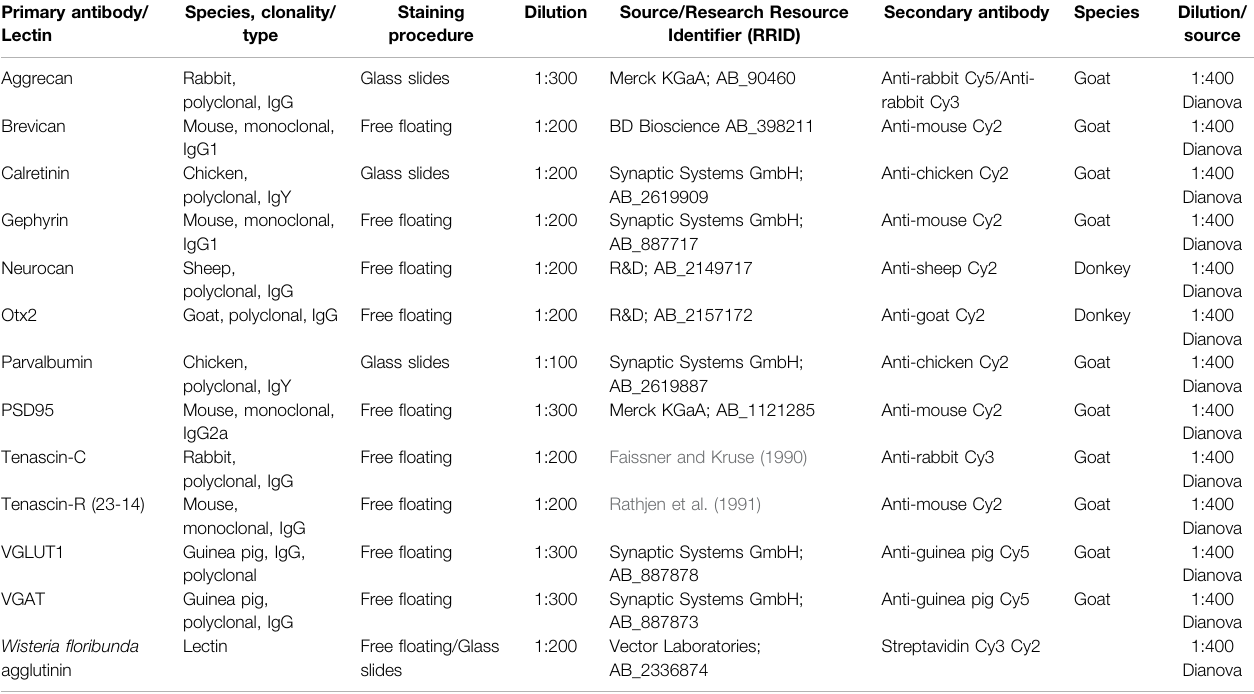
TABLE 1 | Antibodies for immunohistochemical